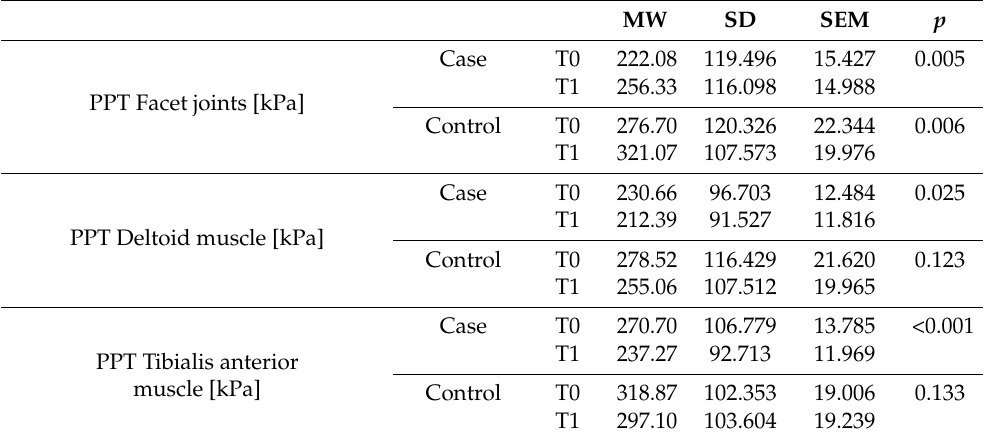
Table 4. Influence of multimodal pain therapy on pressure pain thresholds.